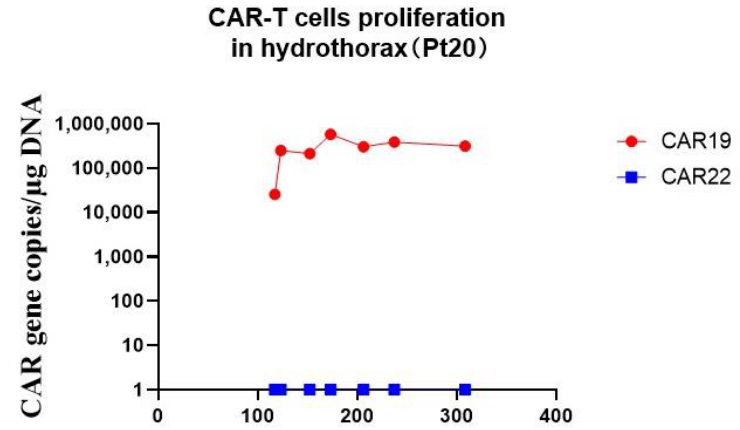
Figure 11. CAR-T cell proliferation in the hydrothorax of Pt20. High and persistent proliferation of CD19 CAR-T cells in the hydrothorax of Pt20 following CAR-T infusion. The CAR19 cells were still detectable one year after infusion.